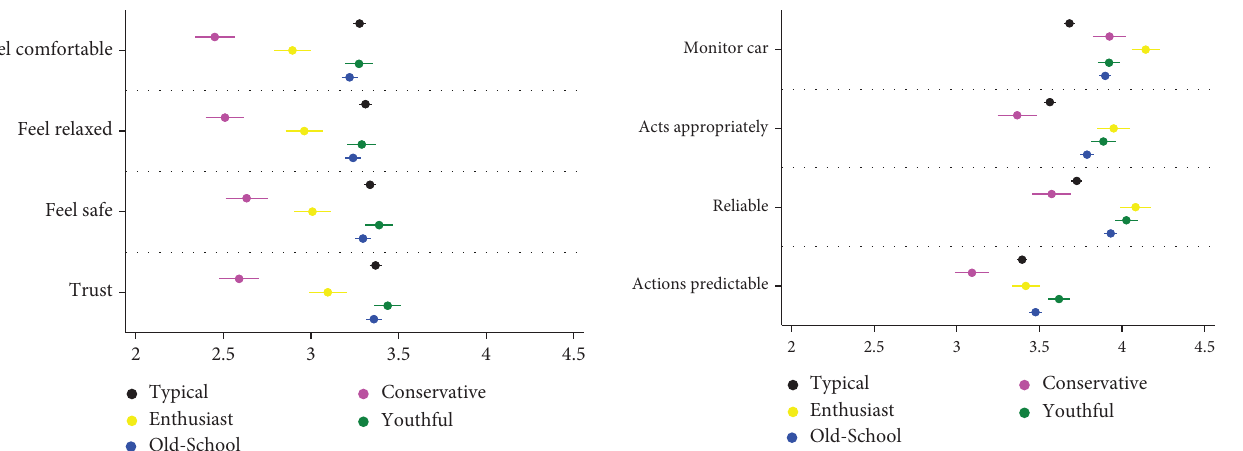
Figure 10: Mean values of attitudinal variables with 95% conf- dence interval by consumer classes. Measured items on the vertical axis: I think I would monitor the car’s performance the whole time to be sure I can safely take over control of the car when needed; I would expect that a CAC would behave appropriately in all situ- ations; I would expect a CAC to be reliable; I believe that the actions of a CAC would be